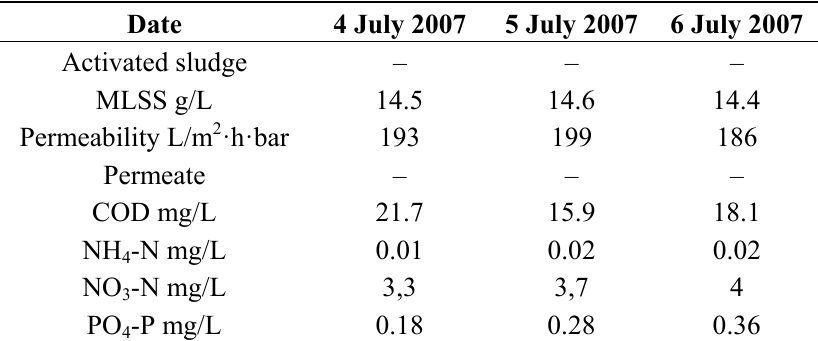
Table 5. Activated sludge and permeate characteristics.